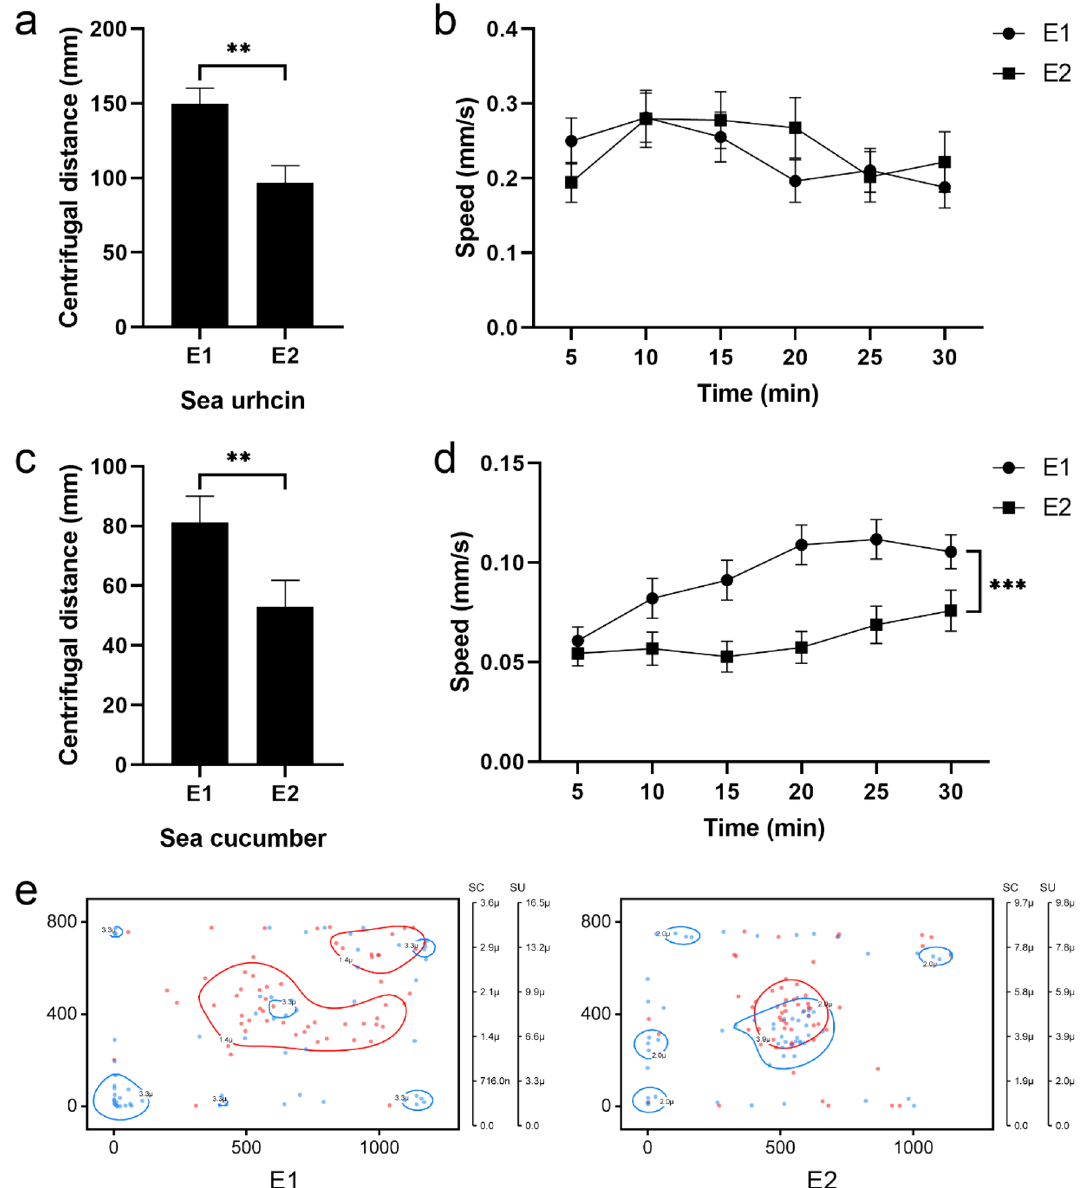
Figure 3. Macroalgae regulate the interactions between sea urchins and sea cucumbers. ( a ) Average centrifugal distance and ( b ) movement speed (mean ± SEM) of sea urchins in groups E1 and E2. ( c ) Average centrifugal distance and ( d ) movement speed (mean ± SEM) of sea cucumbers in groups E1 and E2. ( e ) The position of sea urchins (blue points) and sea cucumbers (red points) in groups E1 and